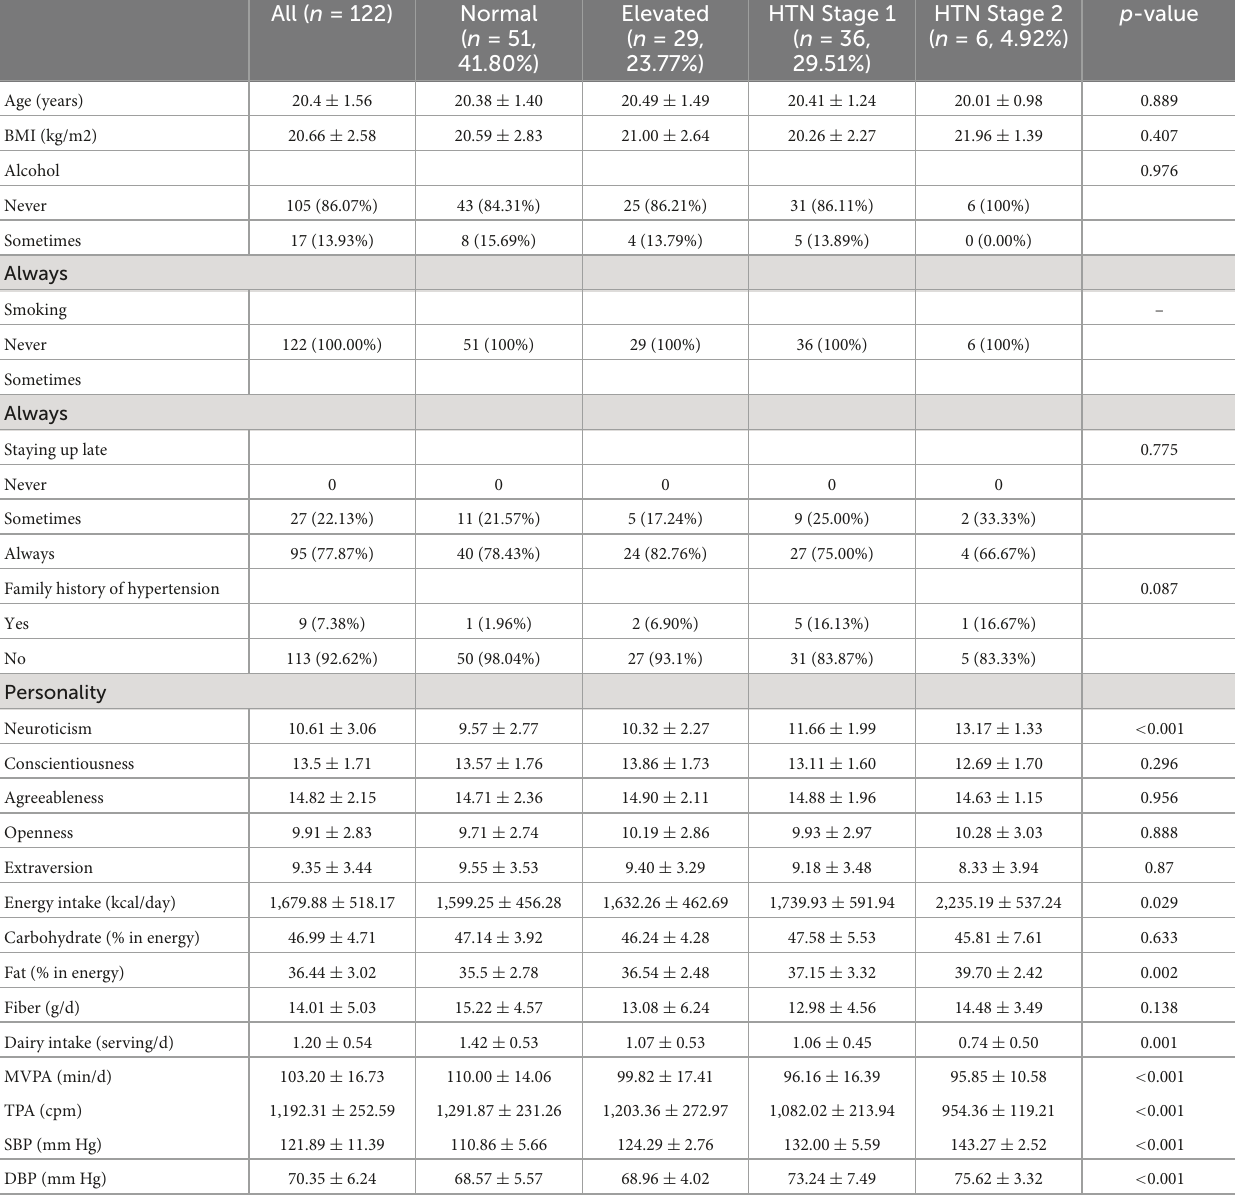
TABLE 1 Characteristics of